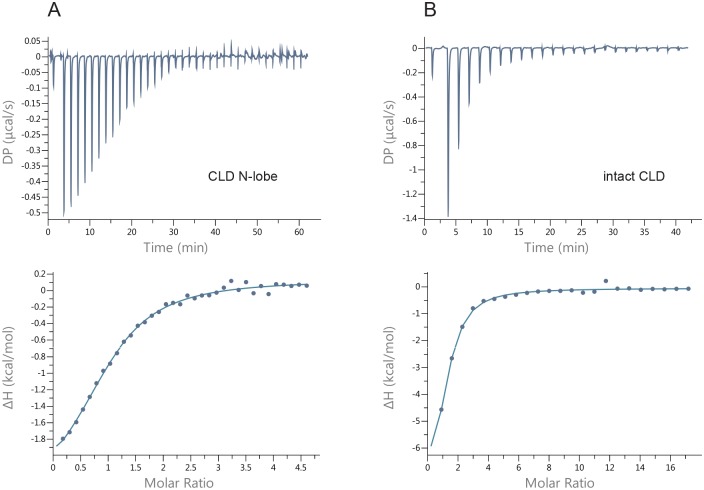
Calcium affinity of (A) CLD N-lobe and (B) CLD analyzed by isothermal calorimetry.The experiments were recorded in triplicates and representative profiles are shown. The data was fitted to a one set of sites binding model. The dissociation constants were 38 ± 3 μM and 18 ± 2 μM for CLD N-lobe and intact CLD, respectively.